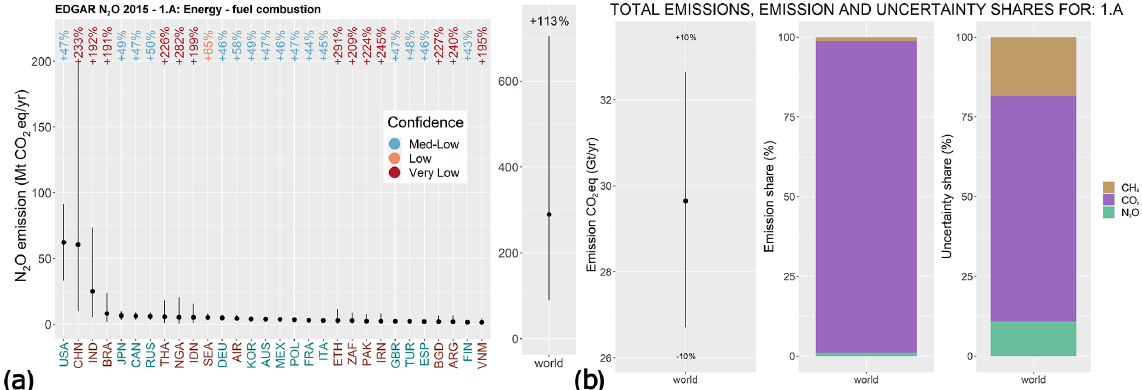
Figure 3. (a) The N 2 O emissions from top emitters and the world for sector 1.A (energy from fuel combustion) when uncertainties are set in the range from ± 50% (industrialized countries) to 150% (developing countries). (b) The world total emission uncertainty and the world emission and uncertainty shares. The country names are colour-coded according to their classification (cyan denotes industrialized, and red denotes developing). Confidence levels are given in the following ranges: high (0%, 10%]; medium-high (10%, 20%]; medium (20%, 40%]; medium-low (40%, 60%]; low (60%, 100%]; and very low > 100 %. (Country codes are given in Table